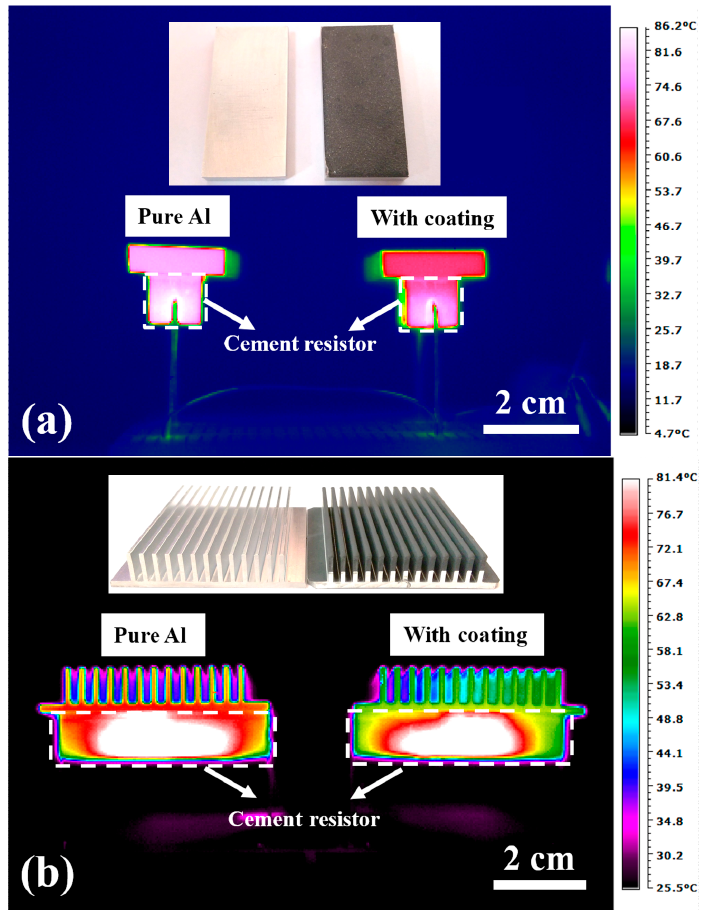
Figure 3. The setup of the thermal dissipation test under infrared imaging. The uncoated Al sample is shown on the left and the mechanically coated Al (this time with Al 2 O 3 + SiO 2 ) is on the right. The Al samples are placed above the cement resistor connected with the power supply: ( a ) plates; ( b ) fins.